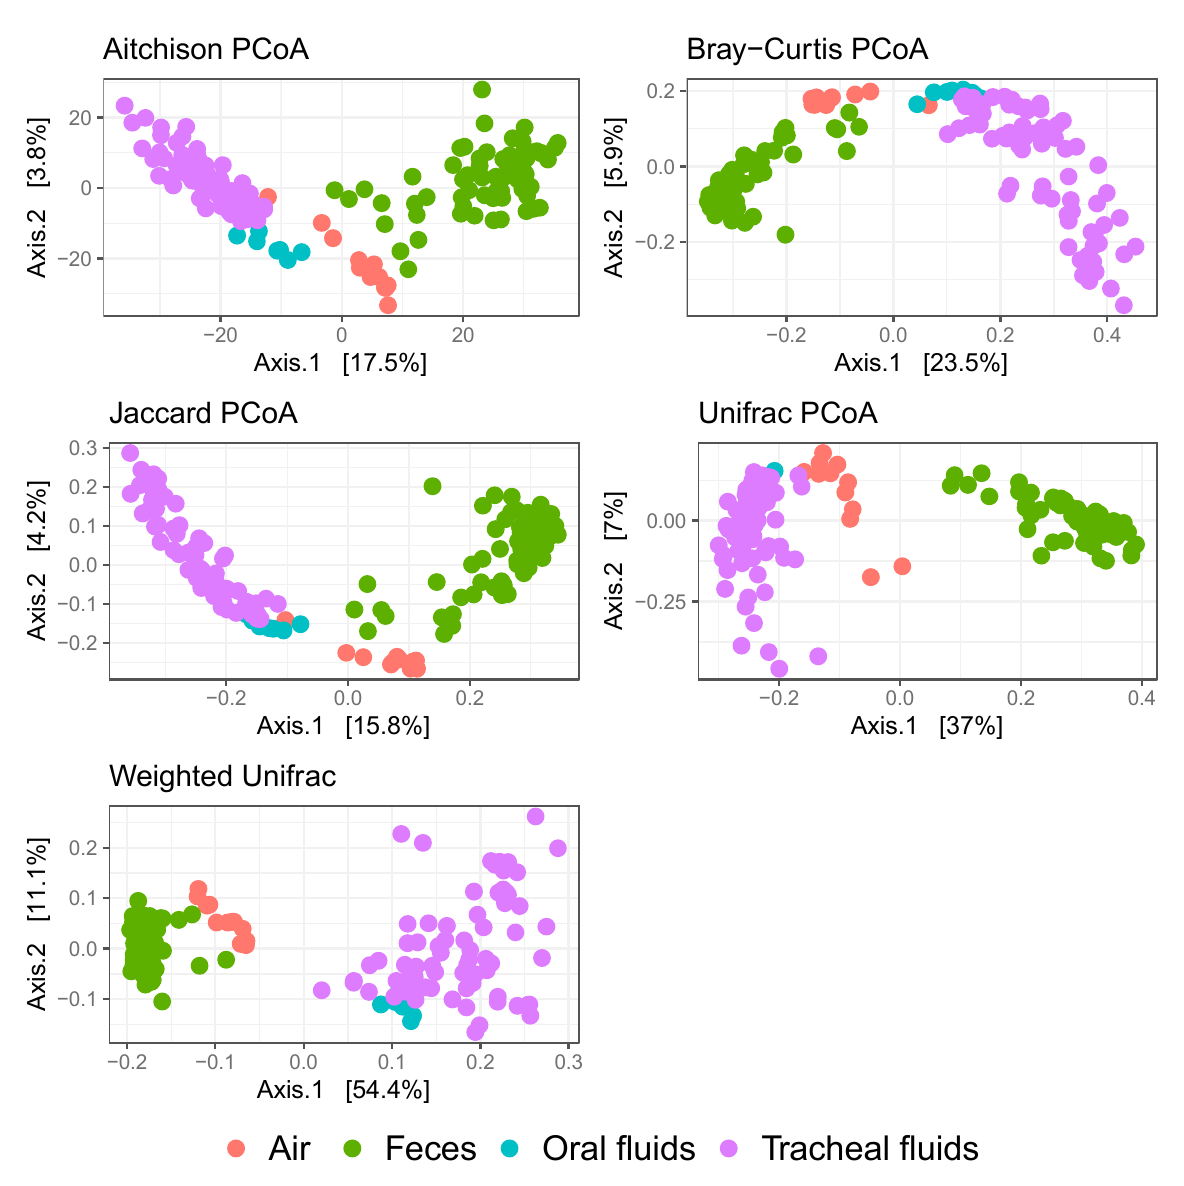
Figure 3. Microbial communities clustering analysis. Each dot represents an individual sample. Five different dissimilarity indices were performed and are shown in the following order (left to right, top to bottom): Aitchison, Bray–Curtis, Jaccard, Unifrac, and weighted Unifrac. Samples are color-coded by type. Orange: air; green: feces; teal: oral fluids; purple: tracheal fluids. Table 3. Association of beta diversity dissimilarity indices with sample type (tracheal fluids and feces) and the interaction of sample type and Mycoplasma hyopneumoniae status.